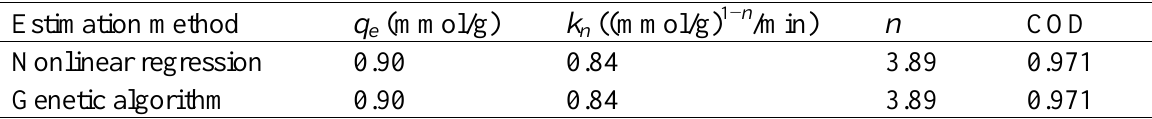
Table 5. Parameter estimation in the n th order rate equation by the nonlinear regression and GA